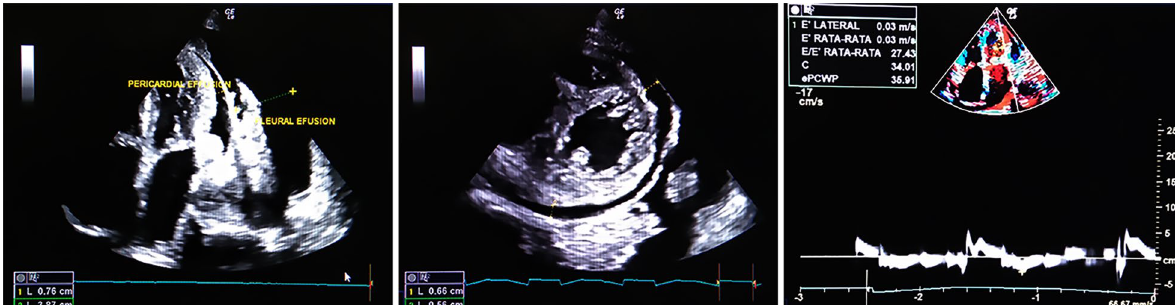
Fig. 3 Transthoracic echocardiogram displayed increased left ventricular filling pressure with diastolic dysfunction grade III, mild circumferential pericardial effusion with adjacent pleural effusion